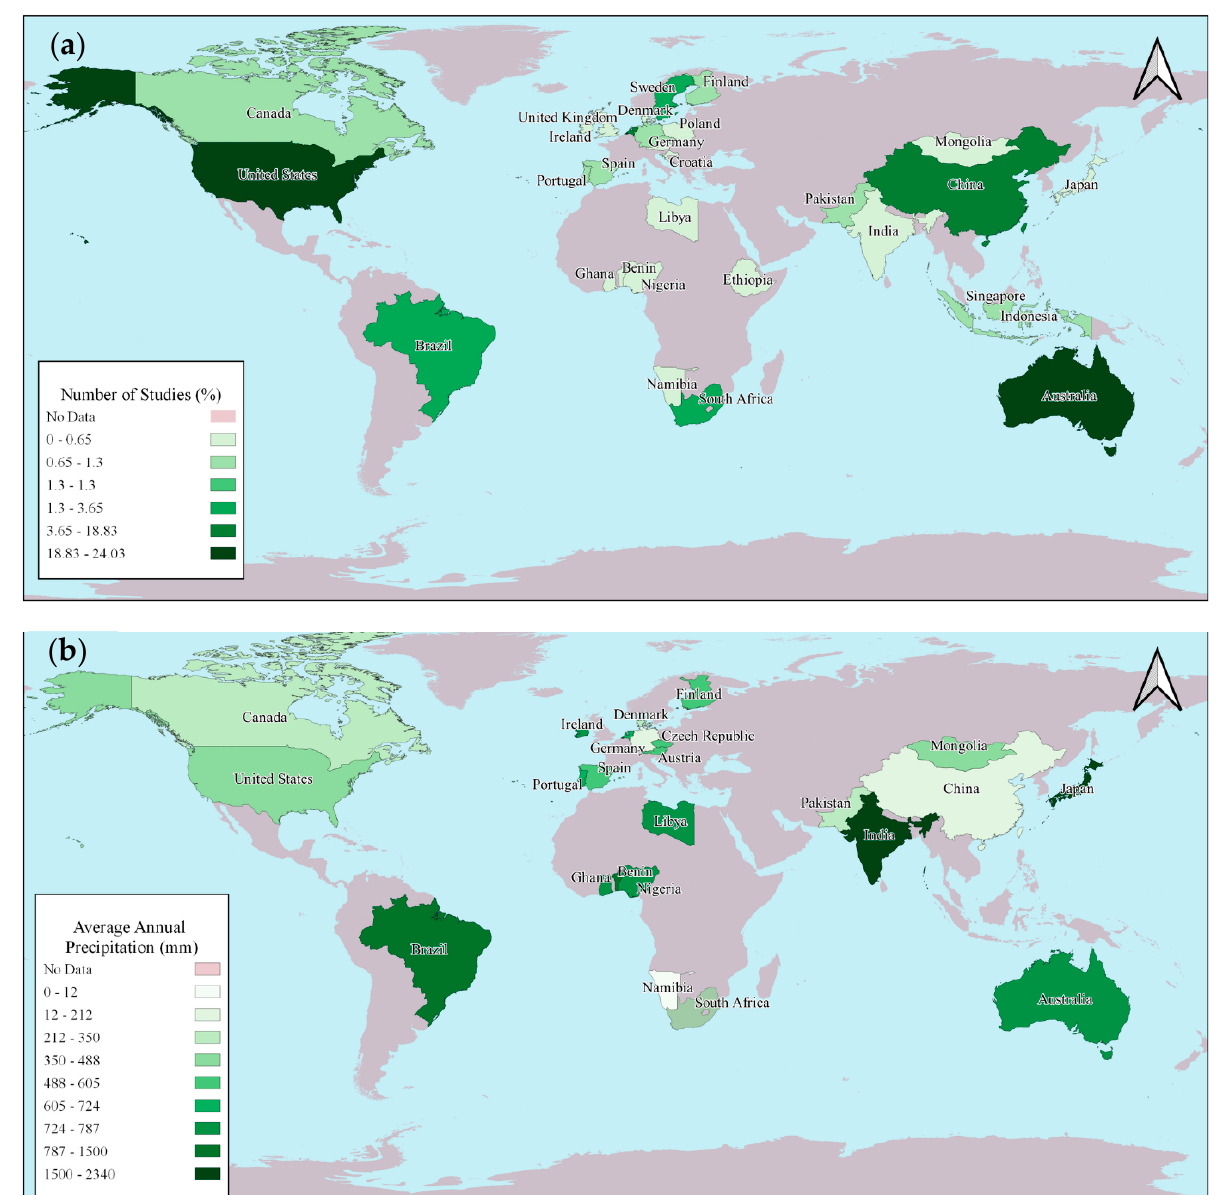
Figure 2. ( a ) Groundwater–vegetation studies by country and ( b ) mean annual precipitation men- tioned in the reviewed literature.